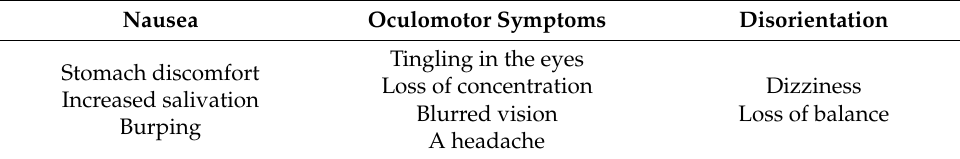
Table 1. Symptoms [38].